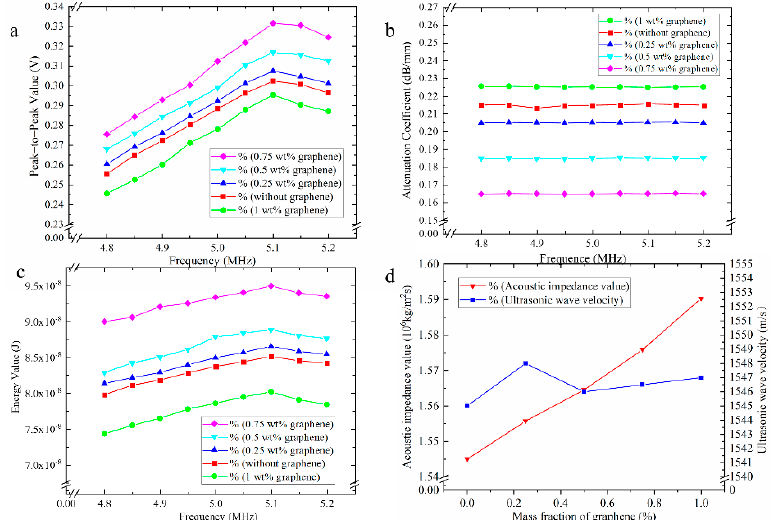
Figure 6. ( a ) Peak-to-peak values, ( b ) Attenuation coefficient, ( c ) Energy value of the received signal with the glycerol–graphene composite coupling agent. ( d ) Acoustic impedance values and ultra- sonic wave velocity of the glycerol–graphene composite coupling agent with the mass fraction of